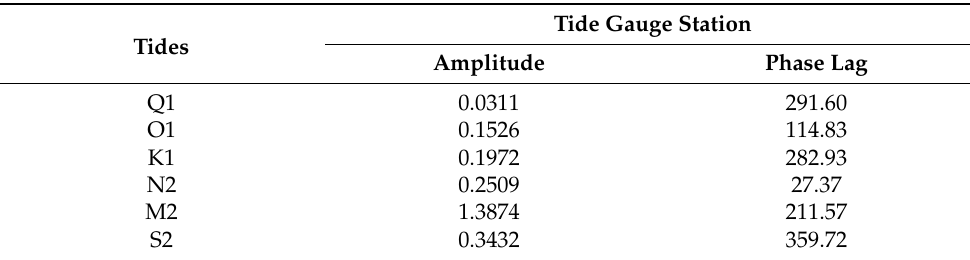
Table 1. Amplitudes (in meters) and phase lag (in degree) of dominant tidal harmonic constituents at the tide gauge station in Figure 1b. Phase lag with reference to 3 September 2016, 00:00 GMT. Tide Gauge Station Tides Amplitude Phase Lag